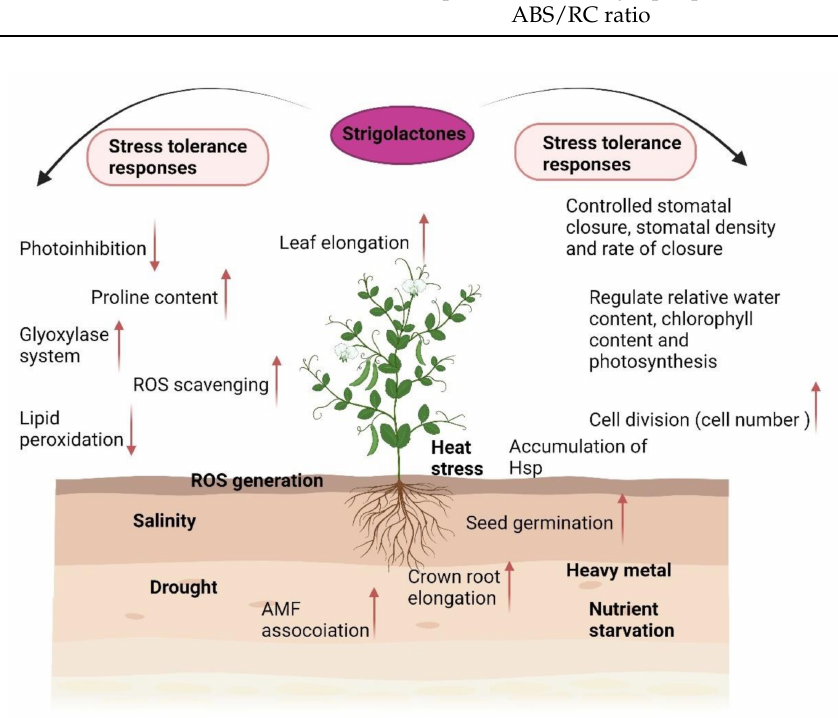
Figure 5. Involvement of strigolactones in plant adaptation to a range of abiotic stresses. ROS (Reactive oxygen species); AMF (Arbasscular Mychorrizal Fungi). Arrows: Increase;